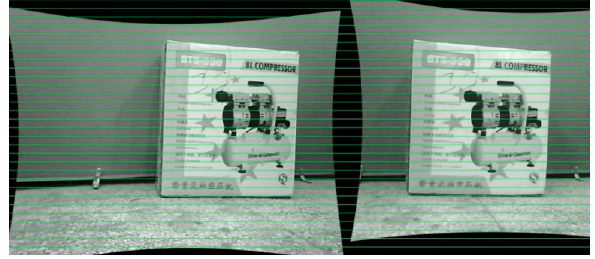
Figure 13. Binocular calibration of our system.